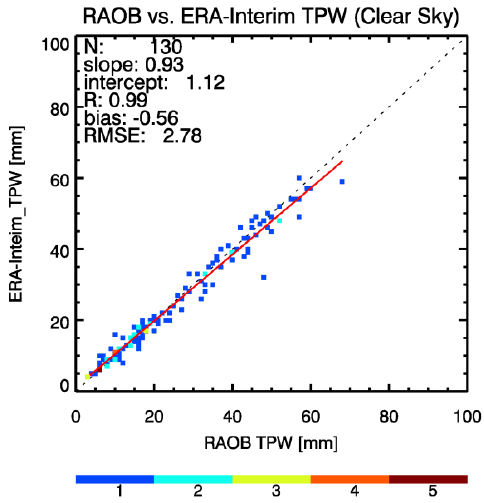
Figure 2. Comparison between RAOB TPW and ERA-Interim TPW in Northeast Asia during the validation period (1st, 25th per month from September 2016 to August 2018). ERA-Interim TPW is collocated with the 13 RAOB stations over a clear sky region. Scatter plots are colored by density: the x-axis is RAOB TPW and the y-axis is ERA-Interim TPW. The red line represents a regression